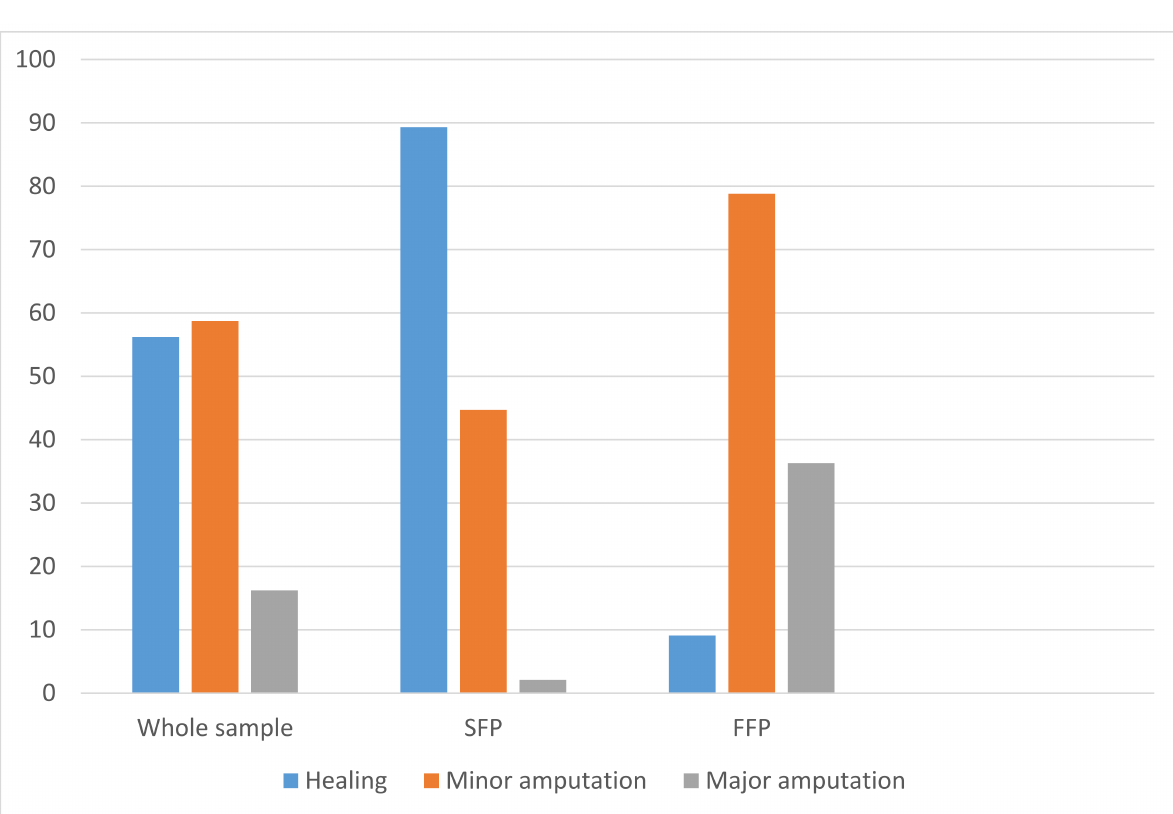
Figure 2. Outcomes for the whole sample, SFP, FFP. SFP: successful foot perfusion; FFP: failed foot perfusion.